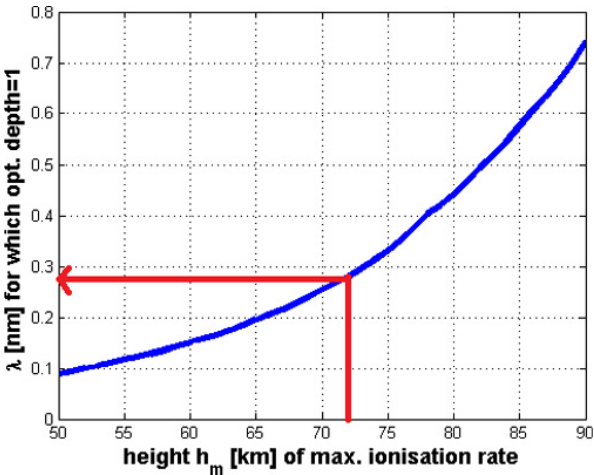
Fig. 1. Penetration depths of X-rays. At a height h m , the optical depth of the wavelength denoted by the function is unity. The fig- ure was generated based on wavelength vs. absorption cross section data from Nicolet and Aikin (1960) and Eq. (7). For example the red arrow points out that a h m value of 72km, which is consistent with our model calculations, is related to a center wavelength of 0.28 nm for the forcing